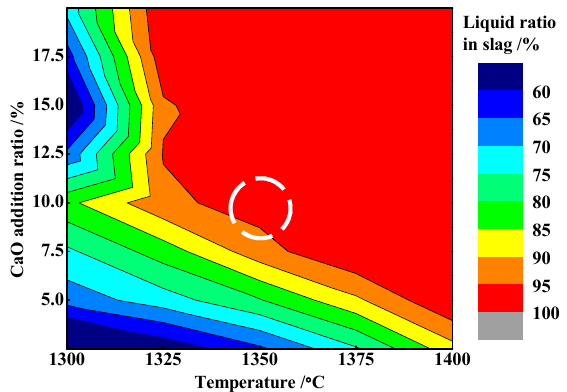
Figure 14. Variation of liquid generation ratio for different CaO additions.